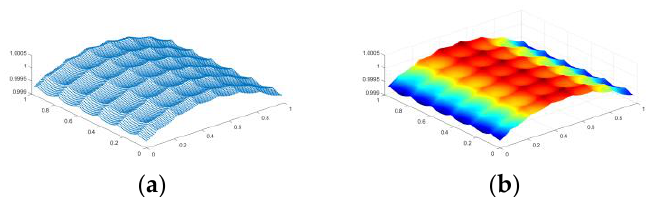
Figure 8. Substitution process of coordinates of discrete points of workpiece.